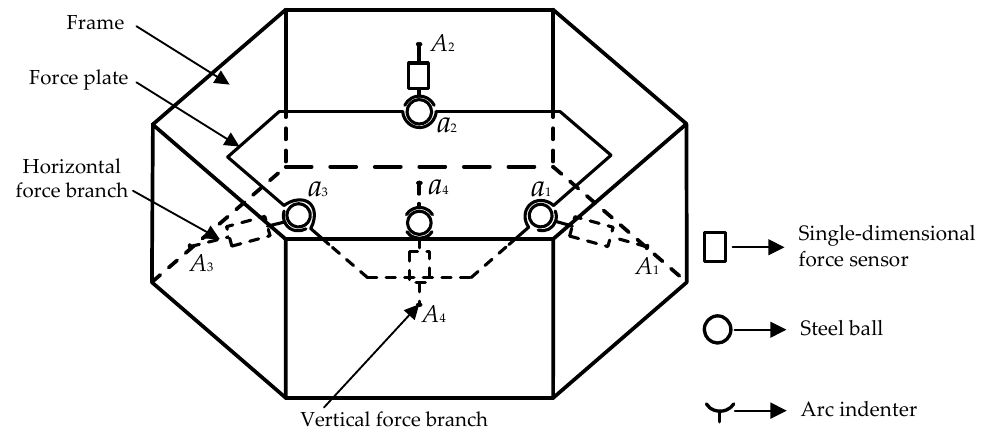
Figure 3. Schematic diagram of the parallel three-dimensional force sensor.